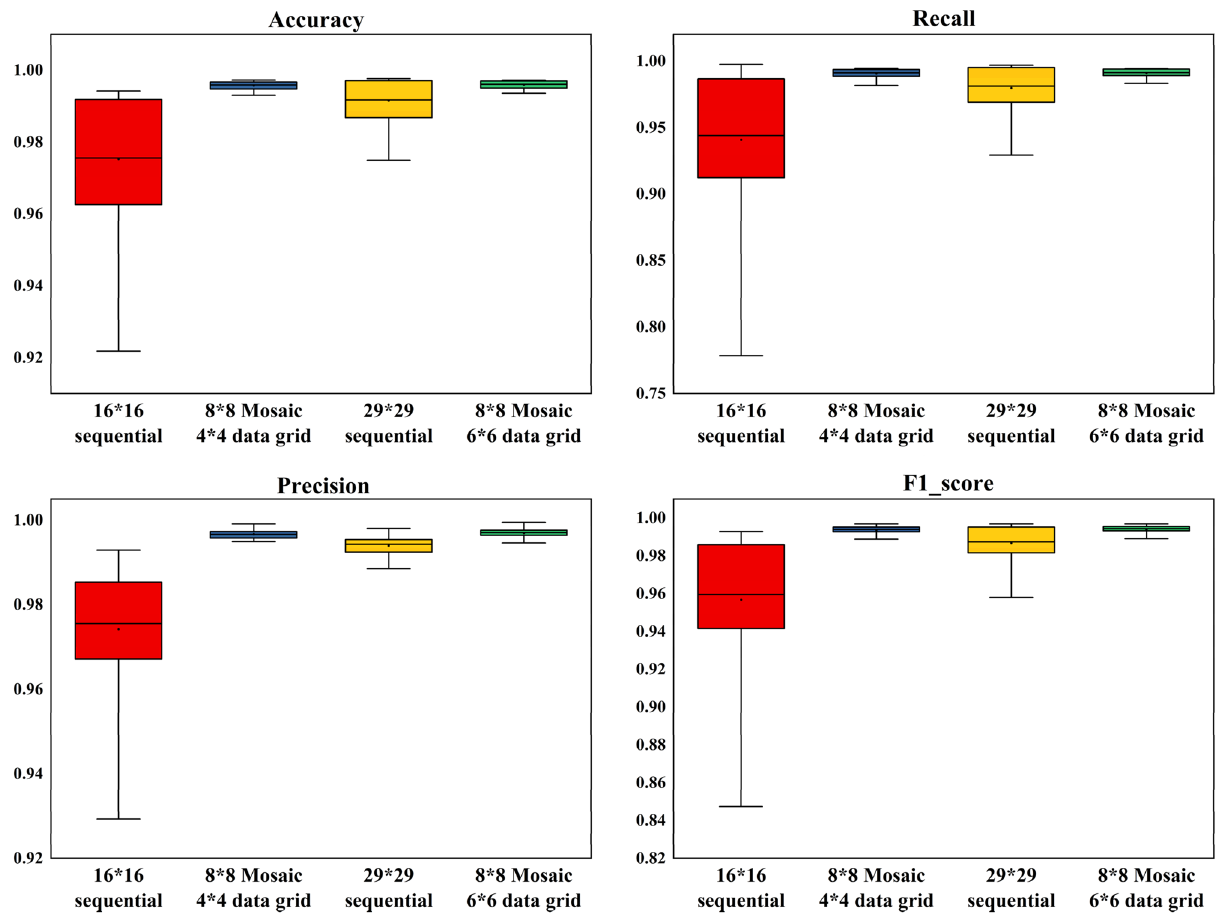
Figure 12. Comparison of box diagram for the test results of various indicators in different methods with the 15 different invasion data combinations given in Table